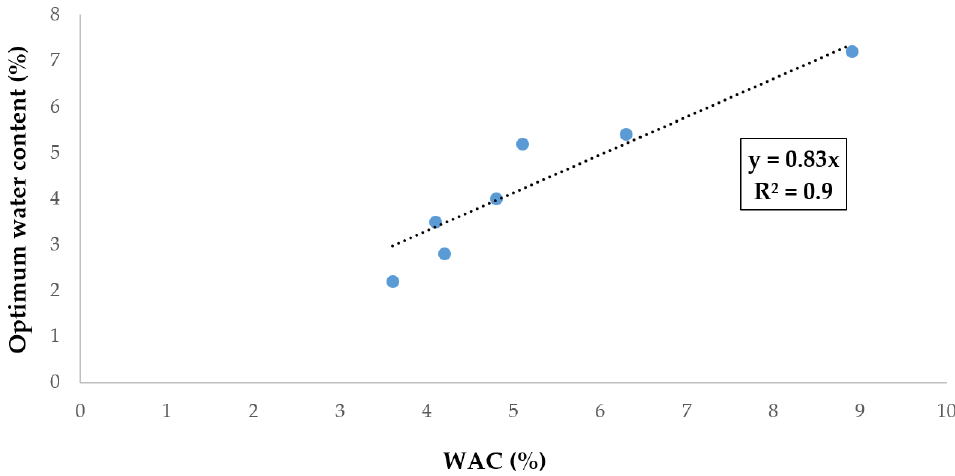
Figure 12. Correlation between optimum water content and water absorption coefficient of an RCA.